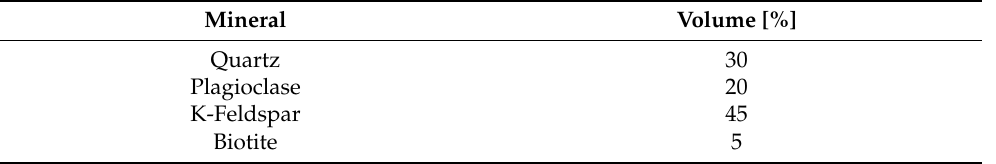
Table 1. Mineral composition of a typical granite